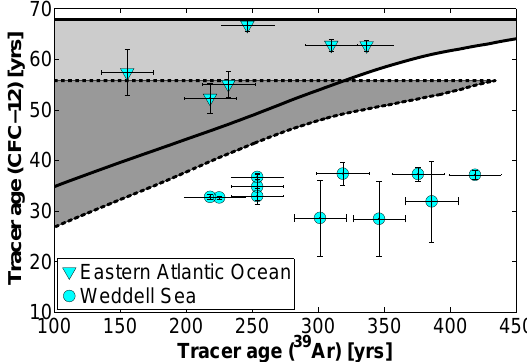
Figure 14. Tracer age relationship of CFC-12 and 39 Ar. The CFC- 12 data of the CLIVAR A13.5 cruise (validity area of 2010, light grey area) were interpolated to the isopycnals of the 39 Ar data of the eastern Atlantic Ocean (cyan triangles). Accordingly, the CFC- 12 data of the ANT-X/4 cruise (validity area of 1992, dark grey area) were interpolated to the 39 Ar data of the Weddell Sea (cyan dots). The validity areas of 1992 (dark grey area) and 2010 (light grey area) correspond to the year of sampling of CFC-12. Data from the eastern Atlantic Ocean (triangles) can be found within the ap- plication range of the IG-TTD, whereas most of the data from the Weddell Sea remain